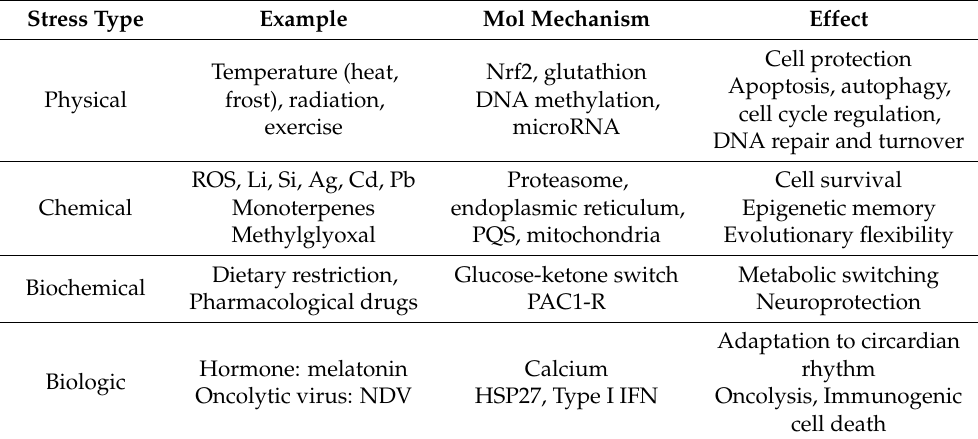
Table 8. Stress adaptation in the global